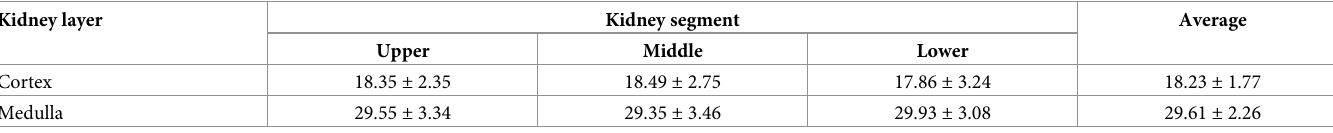
Table 3. R2 � values for the control group.